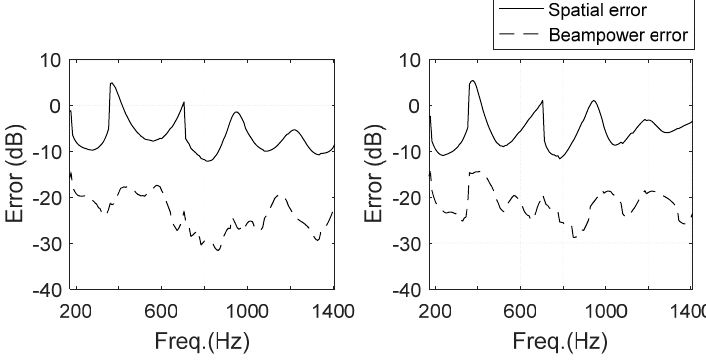
Figure 9. Spatial error and beam-power error in reproduction of a monopole at ‘ a ’ ( left ) and ‘ b ’ ( right ).